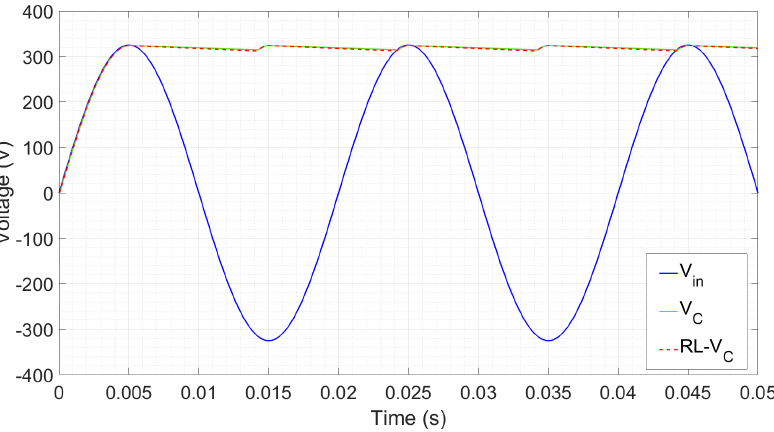
Figure 4. Voltage Waveform Comparison.